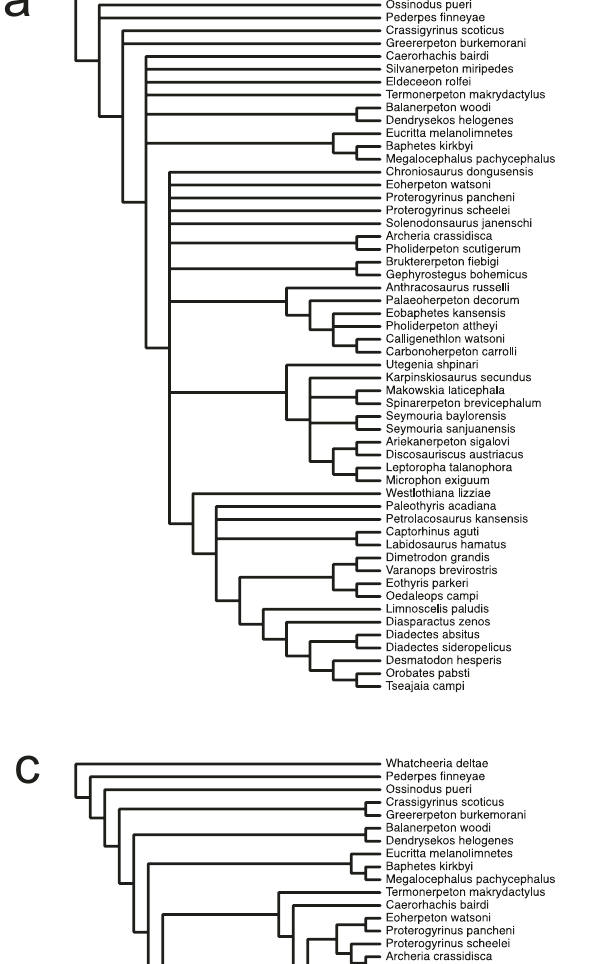
Fig. 5 Results of phylogenetic analyses. a Strict consensus of 120 shortest trees from unweighted analysis (tree length = 1286 steps, ensemble consistency index C.I. = 0.2738 without uninformative characters, ensemble retention index R.I. = 0.5768), b Single tree from implied weights analysis (tree length = 1298 steps, Goloboff fi t = − 202.59266, C.I. = 0.2712, R.I. = 0.5713), c Single tree from reweighted analysis (tree length = 212,68965 steps, C.I. = 0.4755, R.I. = 0.774), d Bayesian topology with branches reporting credibility values.